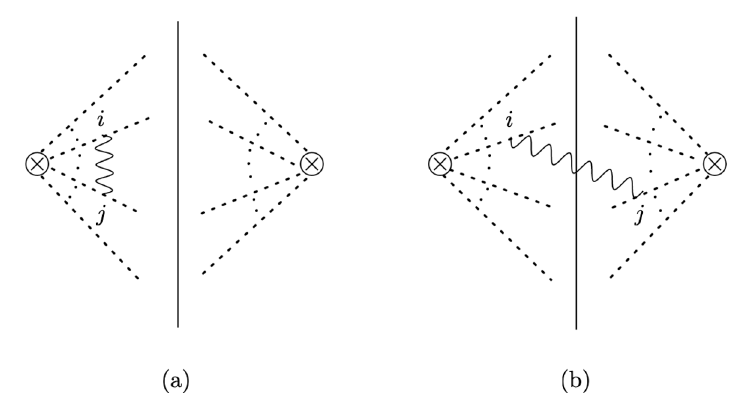
Figure 5 . Schematic diagrams for the emission of a soft gauge boson in S ij . The vertical lines are the final-state cut. Diagram (a) denotes the virtual contribution, and diagram (b) denotes the real contribution. The gauge bosons attached to the same i do not contribute. In order to obtain the soft function, all the possible pairs of contractions with different i and j should be